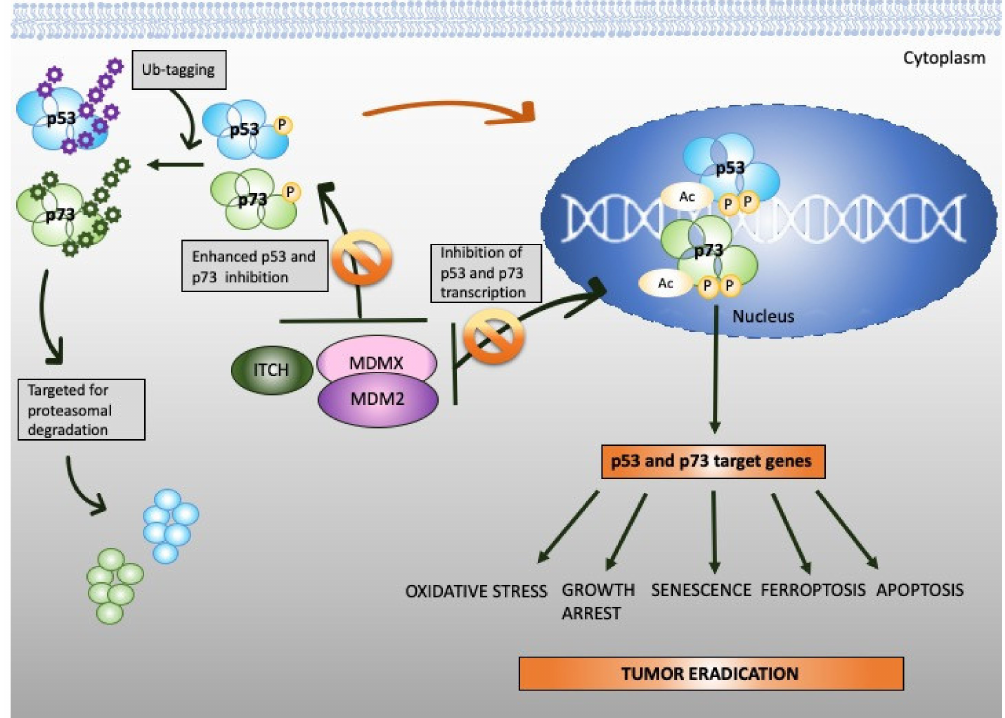
Figure 3. Reinstatement of p53 and p73 to treat cancer. Both p53 and p73 are rendered inactive in tumor cells through enhanced ubiquitination by MDM2 / MDMX and MDM2 / MDMX / ITCH axis, respectively. In addition to enhanced protein degradation, the transcriptional activity of p53 and p73 is inhibited through binding to MDM2 and MDMX. Targeting protein-protein interactions with small molecules or peptidomimetics (orange, crossed circles) stabilizes p53 and p73 and restores their transcription function (orange arrow). This, in turn, promotes tumor eradication through multiple mechanisms, as depicted in the